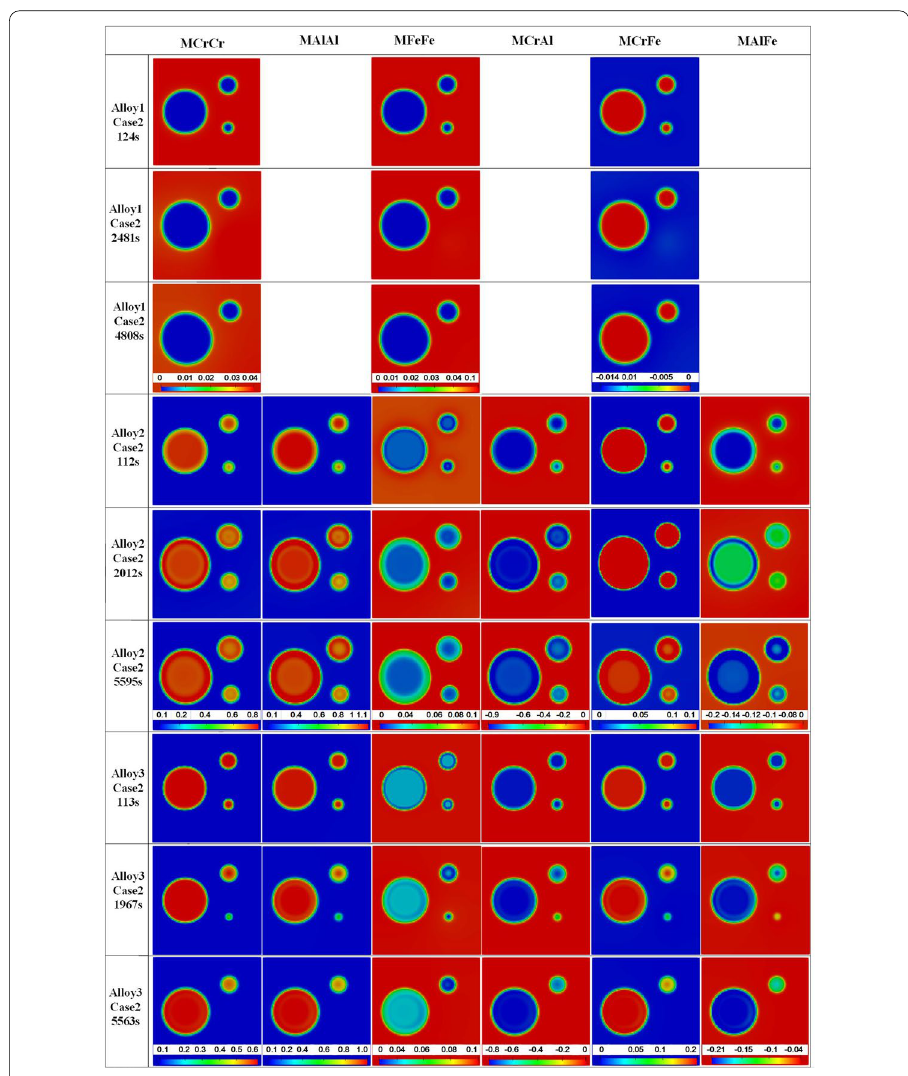
Fig. 10 Interdiffusion mobilities of (Al)CrFeNi